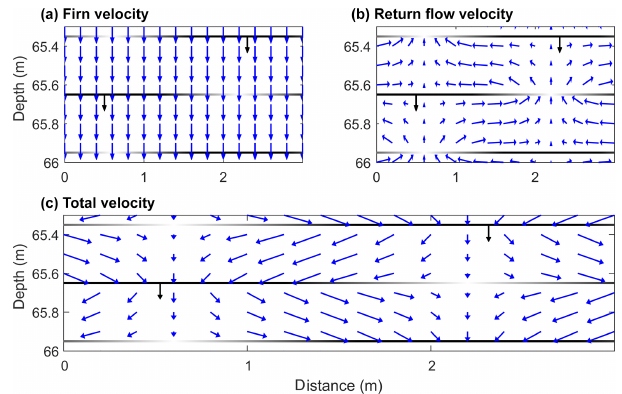
Figure 4. The different components of the velocity field: (a) firn velocity, (b) the velocity of air return flow to the atmosphere due to pore compression, and (c) net firn air advection velocity (a linear combination of the fields in panels a and b ). Because of its alter- nating direction, barometric pumping yields no net flow but instan- taneous flow field patterns look similar to panel (b) . Black arrows indicate the downward advection of layers at the firn